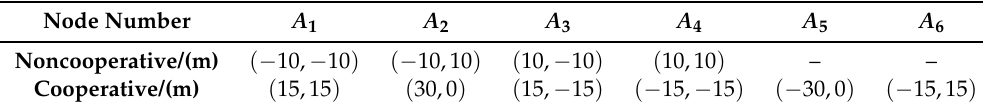
Table 1. Coordinates of the anchors.